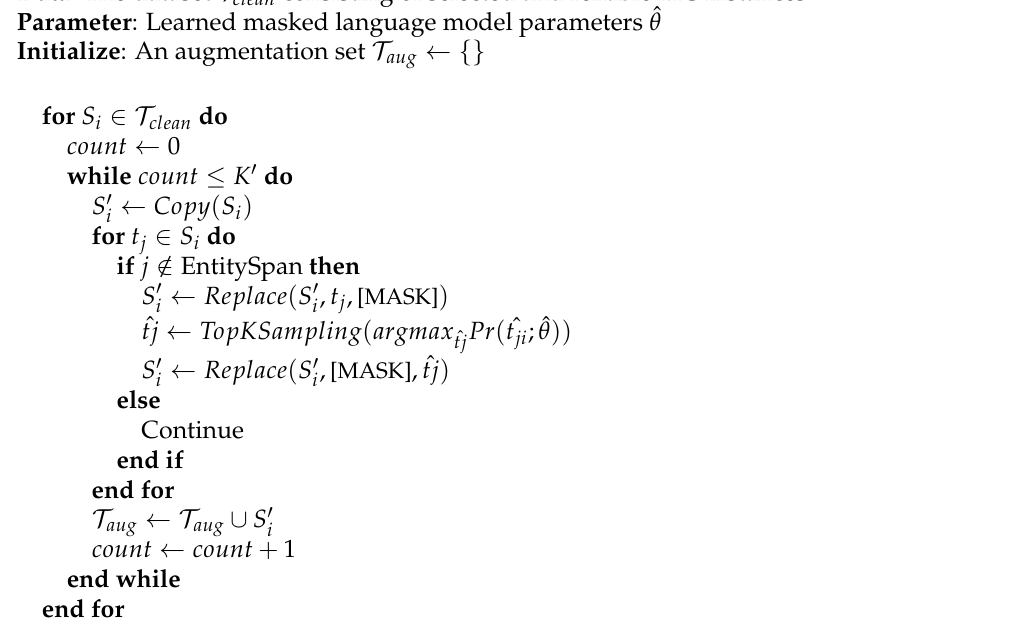
Algorithm 1 Pseudo Code for Generating Augmentation